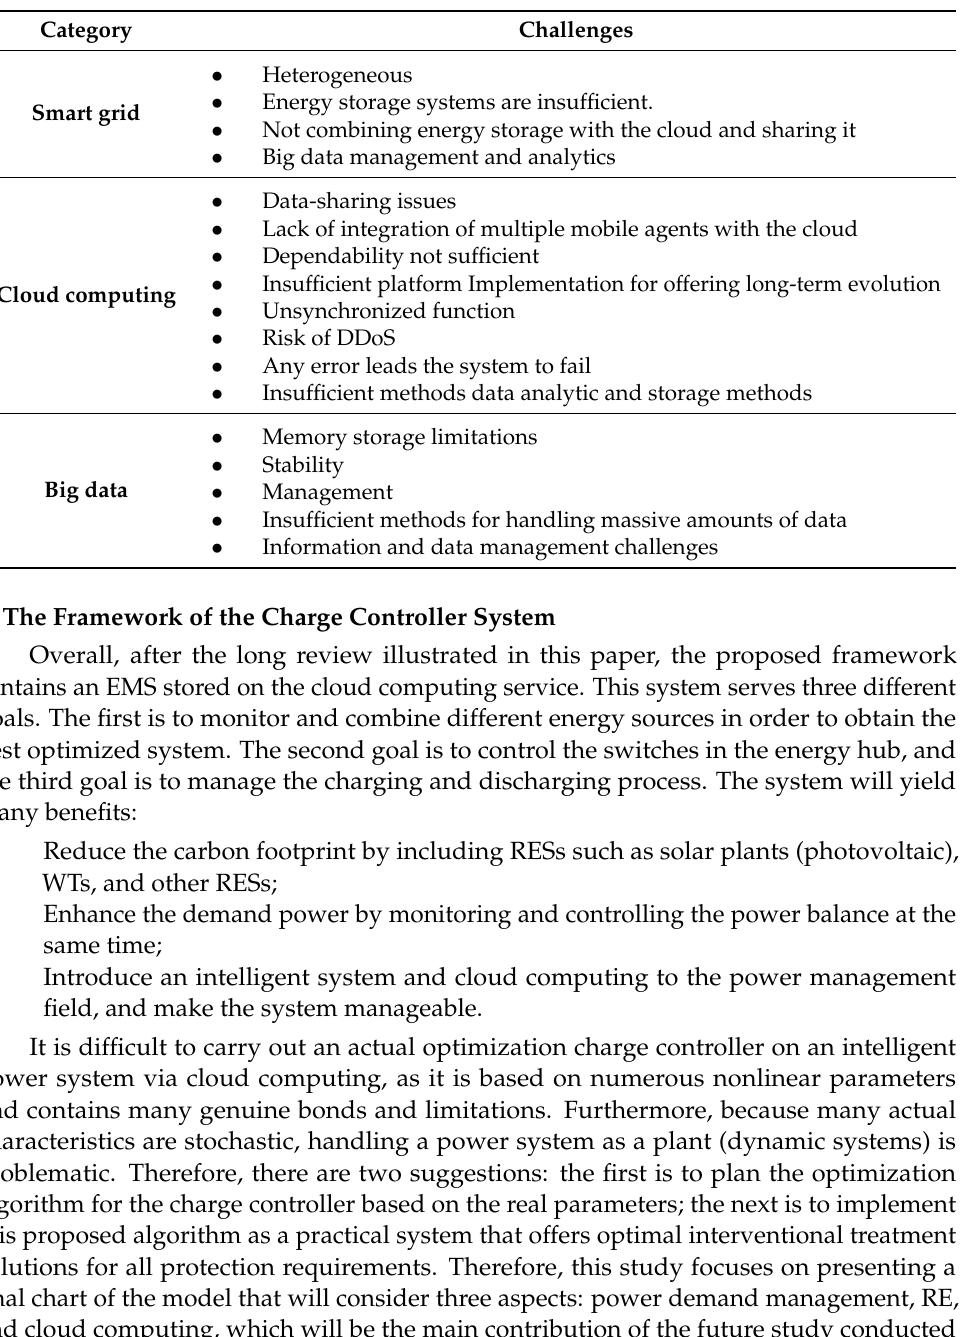
Table 5. Main features of big data in smart